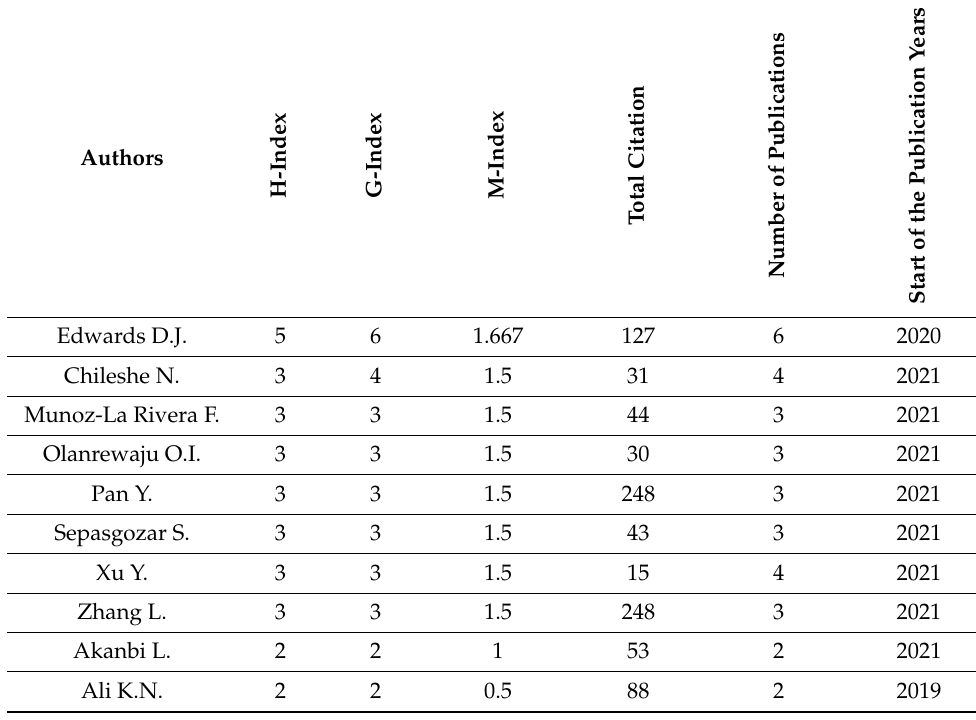
Table 6. Authors’ impact analysis performed with Biblioshiny version 4.0.